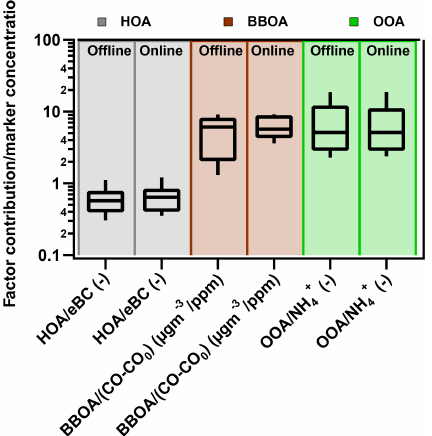
Figure 12. Ranges of ratios of the contribution of different factors to their markers for the offline (corrected with R k ) and online ACSM source apportionment results. Note that OOA is the sum of OOA1 and